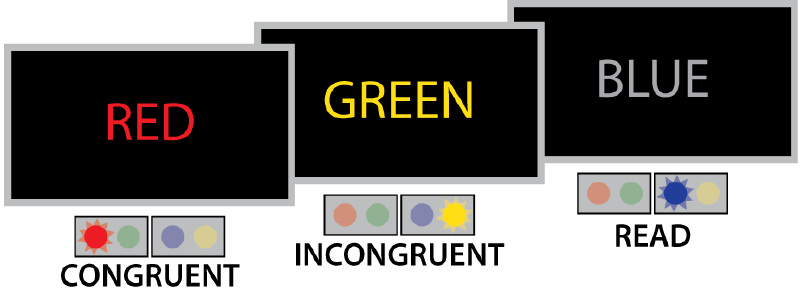
Figure 1. In a modified version of the Stroop task, congruent (CONG) trials consisted of color words displayed in matching colored font, incongruent (INCONG) stimuli had mismatched color words and font, and (READ) trials displayed the name of a color in a grey font. The task was to press a button corresponding to the color of the font or to the meaning of the words presented in gray. Trials were presented for 300 ms every 2 s in an optimally randomized manner.